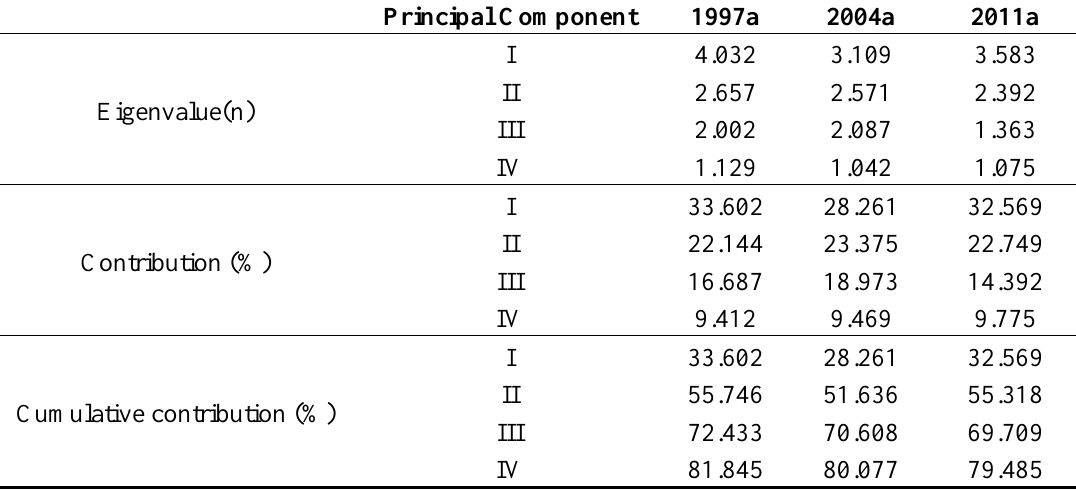
Table 1. The results of spatial principal component